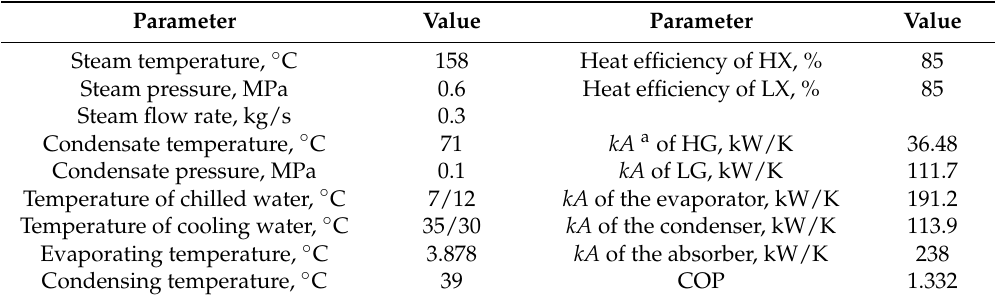
Table 4. Design parameters and performances of the absorption chiller on the work conditions. HG—high-pressure generator; HX—high temperature exchanger; LG—low-pressure generator; LX—low temperature heat exchanger; COP—coefficient of performance.